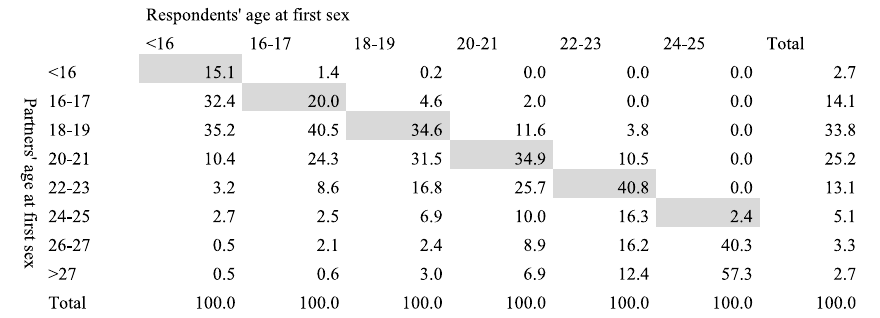
Table 4 Age matrices at first sexual intercourse of female survey respondents and their male partners, 2000 SELFY